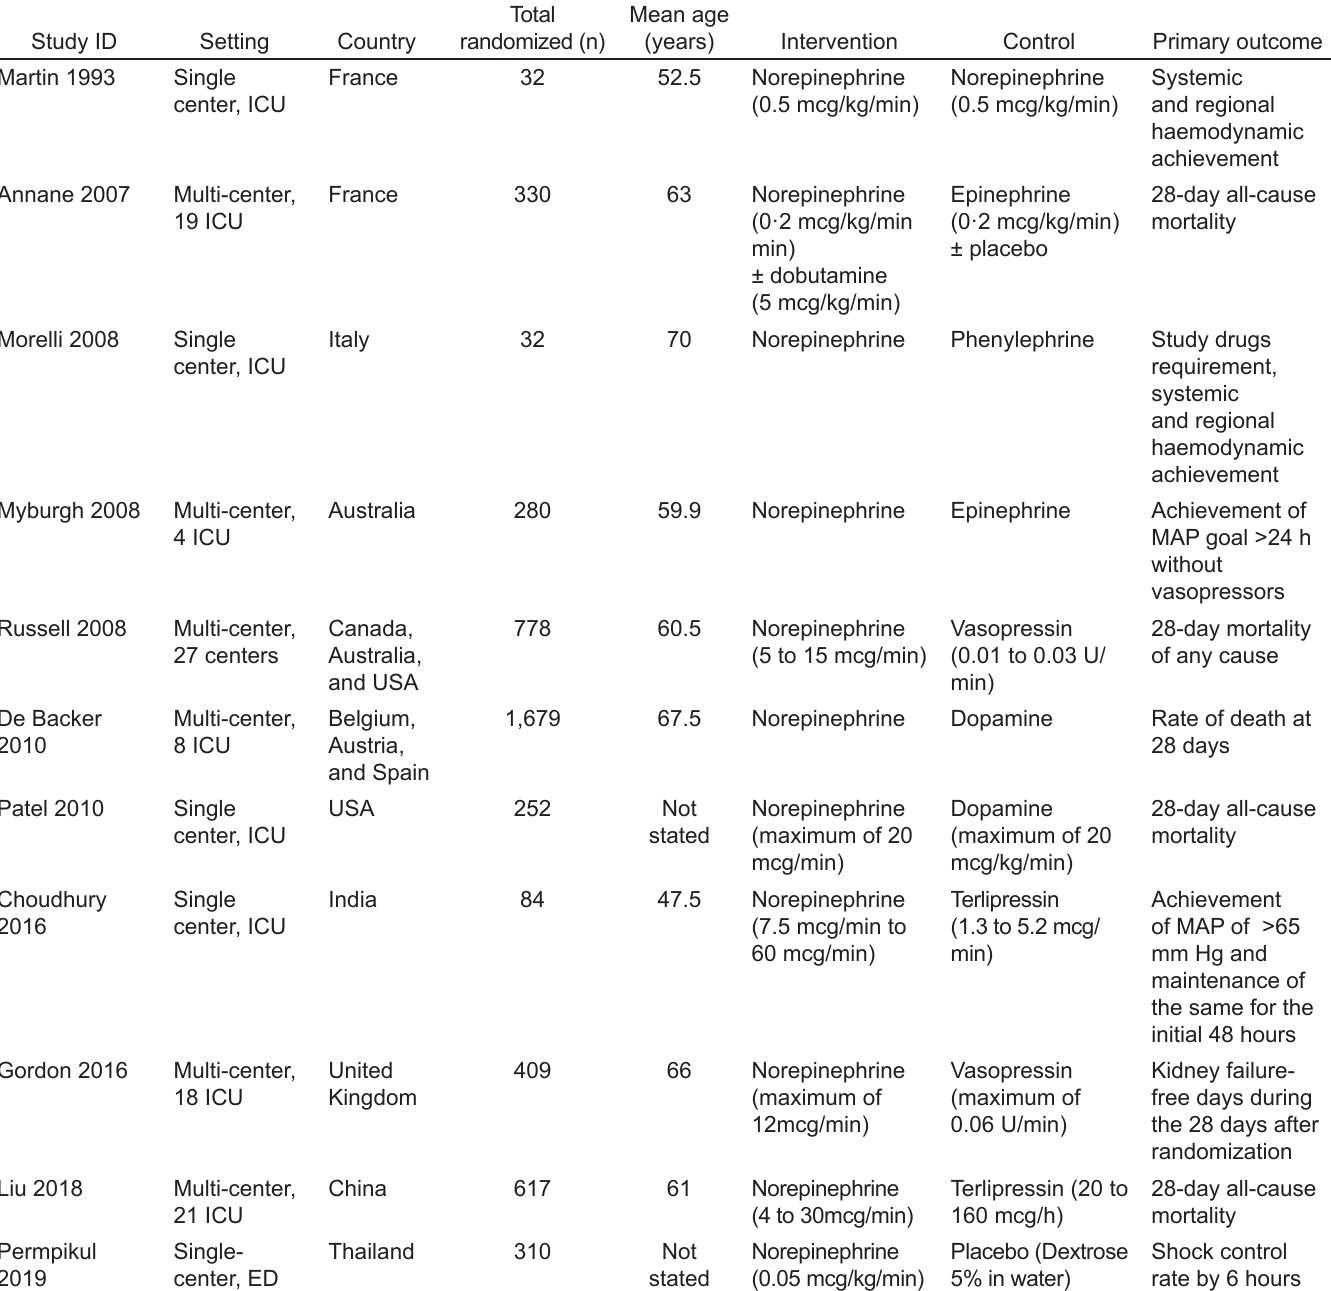
Table. Summary of included